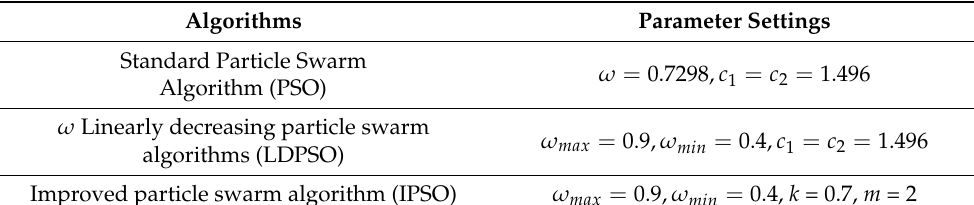
Table 1. Algorithm